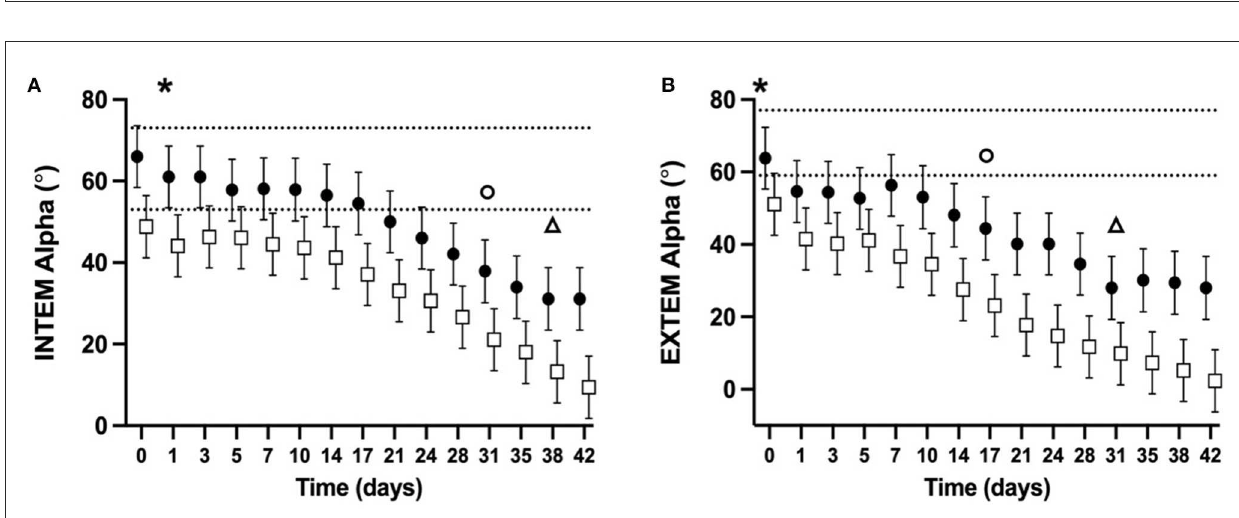
FIGURE3 Serial estimated marginal means and 95% confidence intervals for the INTEM (A) and EXTEM (B) alpha-angle of whole blood (CSWB) from non-greyhound ( • ) and greyhound ( (cid:3) ) dogs cold-stored for 42 days. The open triangle ( 1 ) and open circle (o) denotes when the estimated marginal mean falls below 50% of baseline for non-greyhound and greyhound CSWB, respectively. The dotted lines represent the institutional reference interval for freshly collected non-greyhound dog citrated whole blood. The asterisk (*) indicates when the lower bound of the 95% confidence interval for non-greyhound CSWB falls below the institutional reference interval for citrated whole blood. No greyhound ROTEM reference intervals are available for